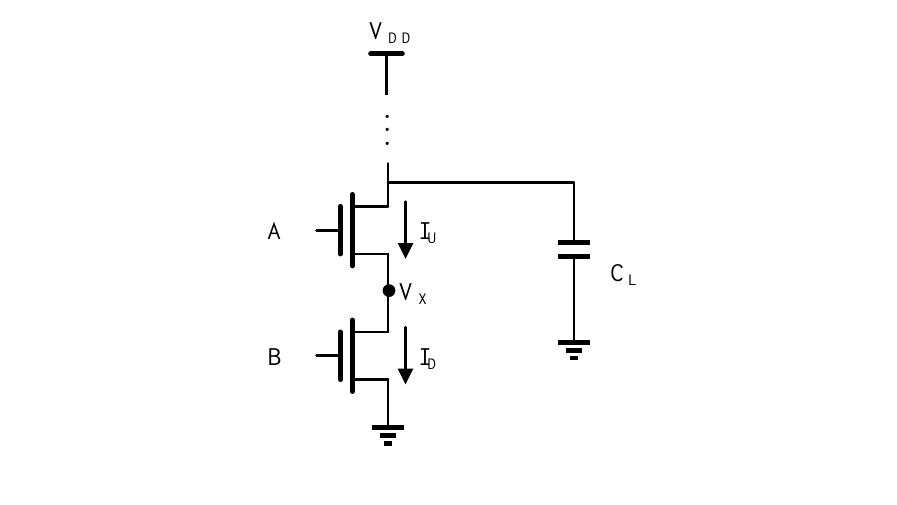
Figure 1. The schematic of stacked transistors.